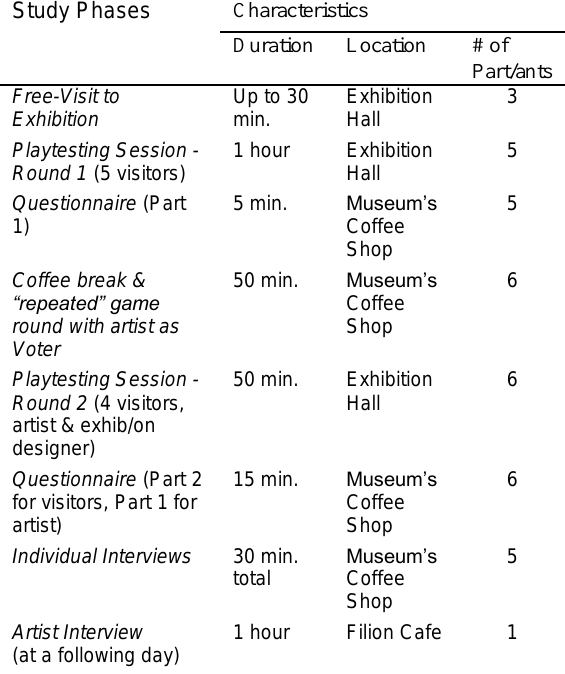
Table 2. Overview of user study